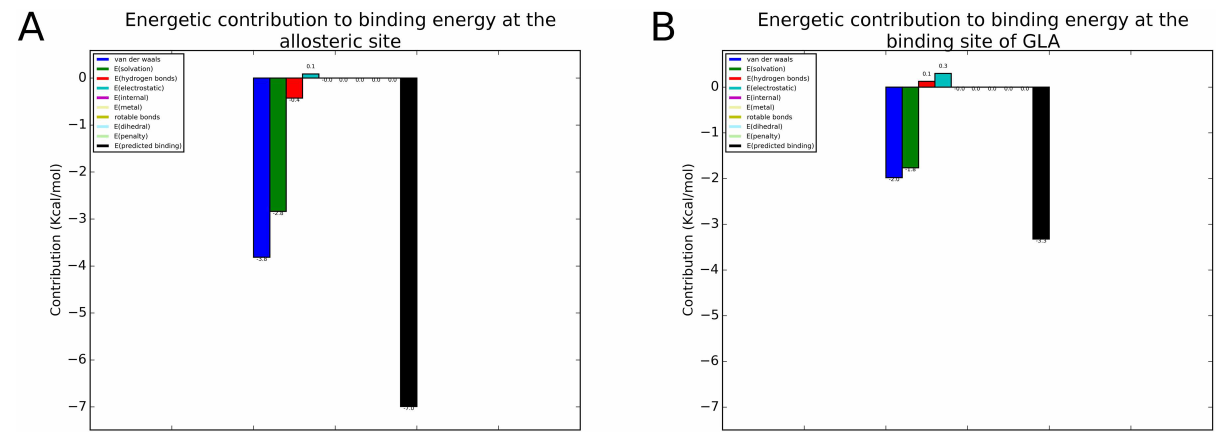
Fig 2. Energetic contributions to the binding of 2–6 dithiopurine to the allosteric site and the active site of human lysosomal alpha-galctosidase. Depicted energetic contributions are: van der Waals interactions (dark blue), volume-based free energy of solvation (green), hydrogen bonds (red), electrostatic energy (cyan), internal energy (pink), metal interactions (light yellow), energy of entropic losses associatedwith ligand’srotatable bonds (dark yellow), dihedralenergy (light blue), internal energy penalty (light green) and total predicted bindingaffinity (black). A) Decomposition for the allosteric site, and B), decomposition for the active site.